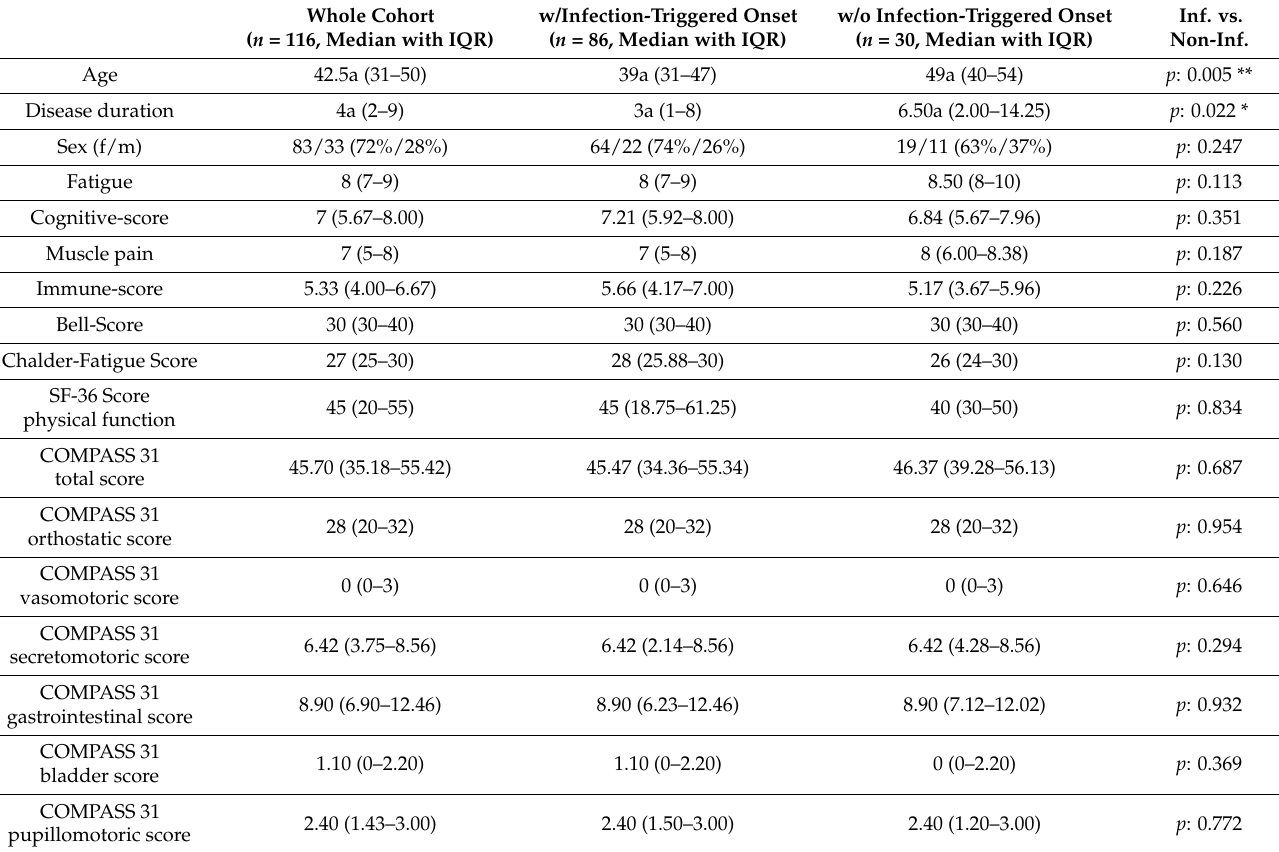
Table 1. Clinical characteristics. Asterisks mark significant differences between groups (Mann–Whitney test, * p < 0.05, ** p < 0.01). Whole Cohort w/Infection-Triggered Onset w/o Infection-Triggered Onset ( n = 116, Median with IQR) ( n = 86, Median with IQR) ( n = 30, Median with IQR)